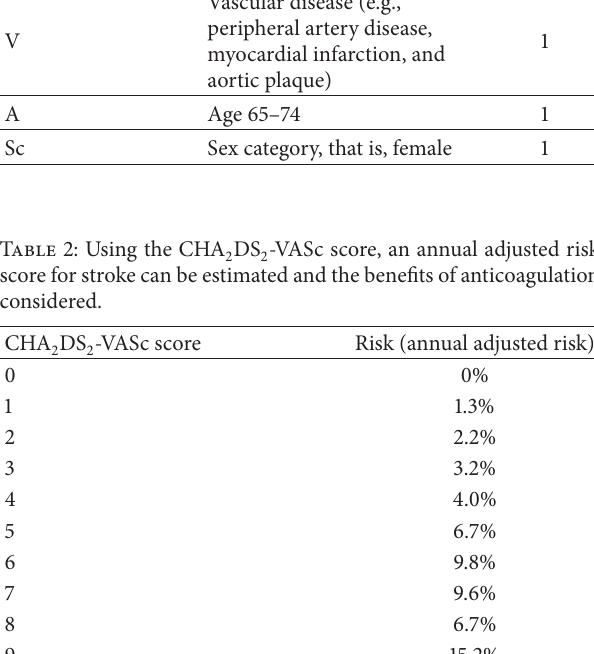
DS -VASc score, an annual adjusted risk 2 2